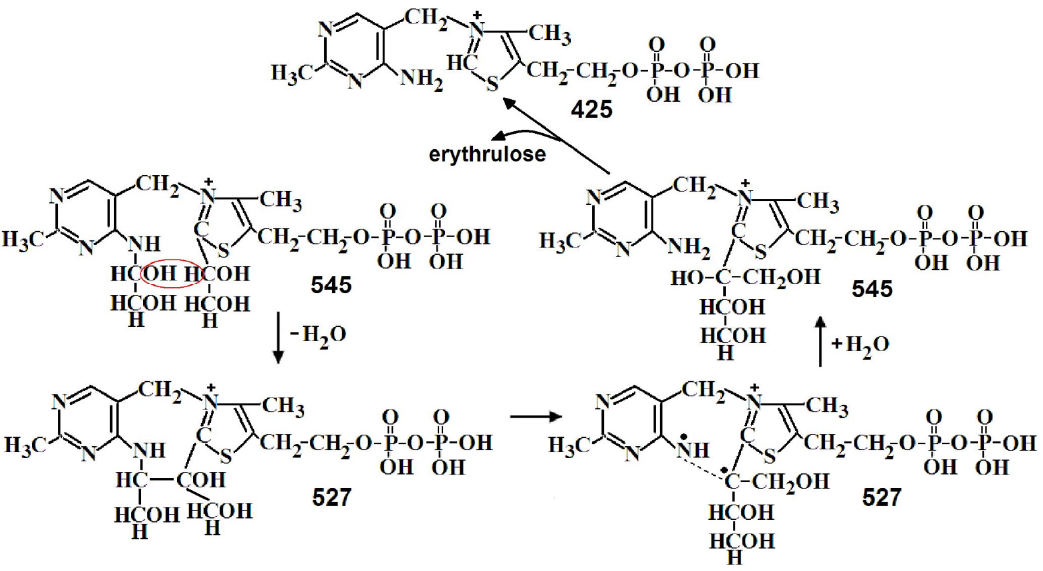
Figure 8. Proposed mechanism of the second stage of the one-substrate transketolase reaction.